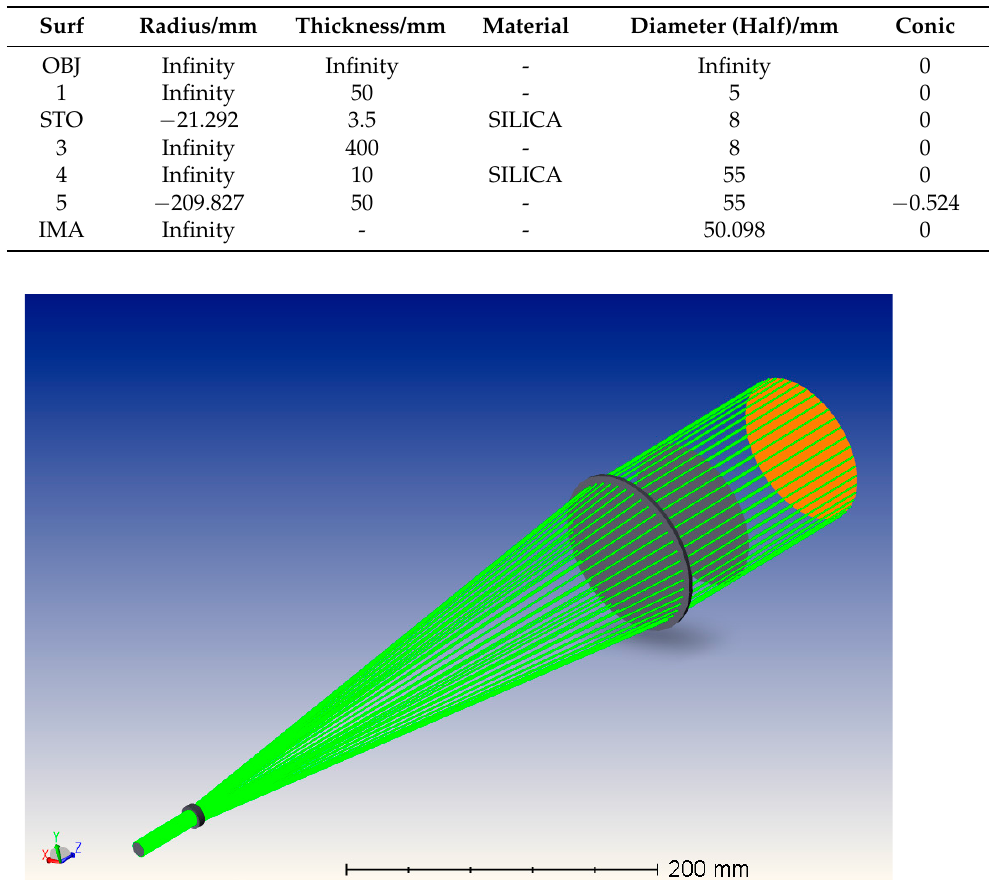
Figure 8. The Beam expander emission light path diagram